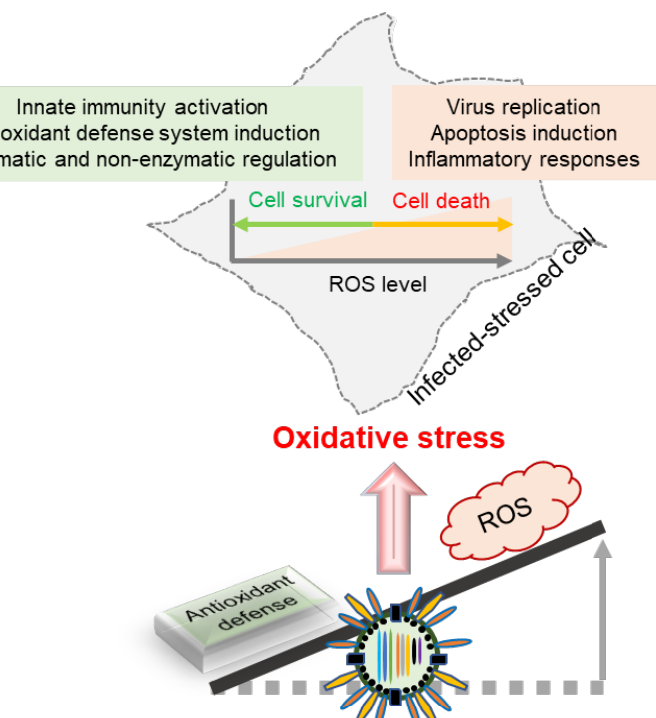
Figure 3. Impact of oxidative stress upon IAV infection. The overproduction of ROS contributes to different pathological changes (i.e., virus replication and cellular inflammation) and leads to apoptosis. On the other hand, medium levels of ROS may induce antioxidant defense systems to control redox homeostasis and promote cell survival in the infected cells.